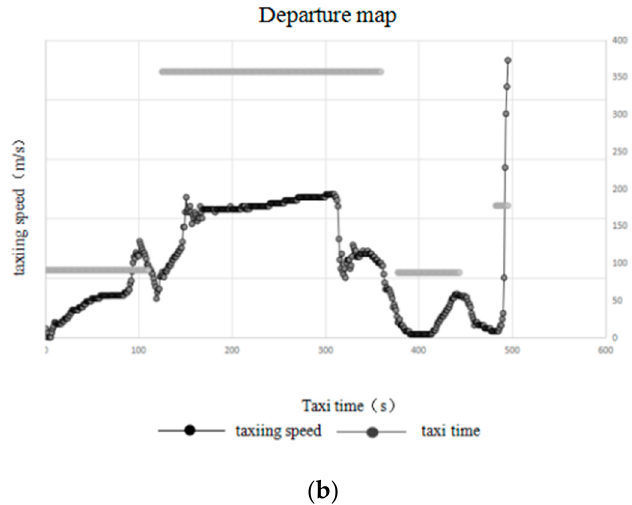
Figure 1. Approach and departure aircraft movement state diagram. ( a ) Arrival aircraft and ( b ) departure aircraft.